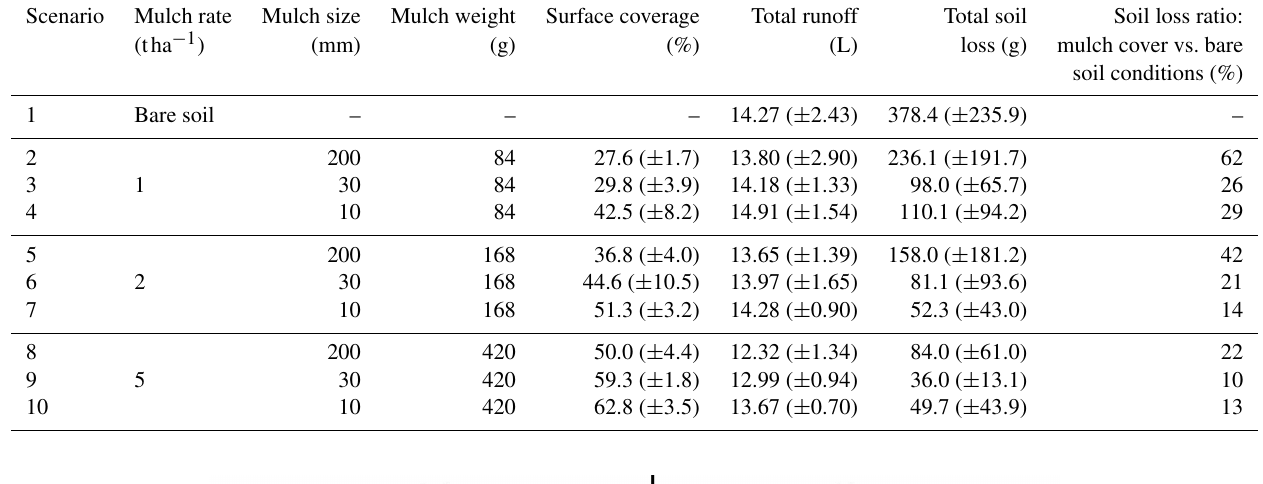
Table 3. Mulch surface coverage, total runoff, total soil loss and ratio between soil loss for mulch cover and bare soil conditions. Average values and standard deviation (between brackets) are for three repetitions.